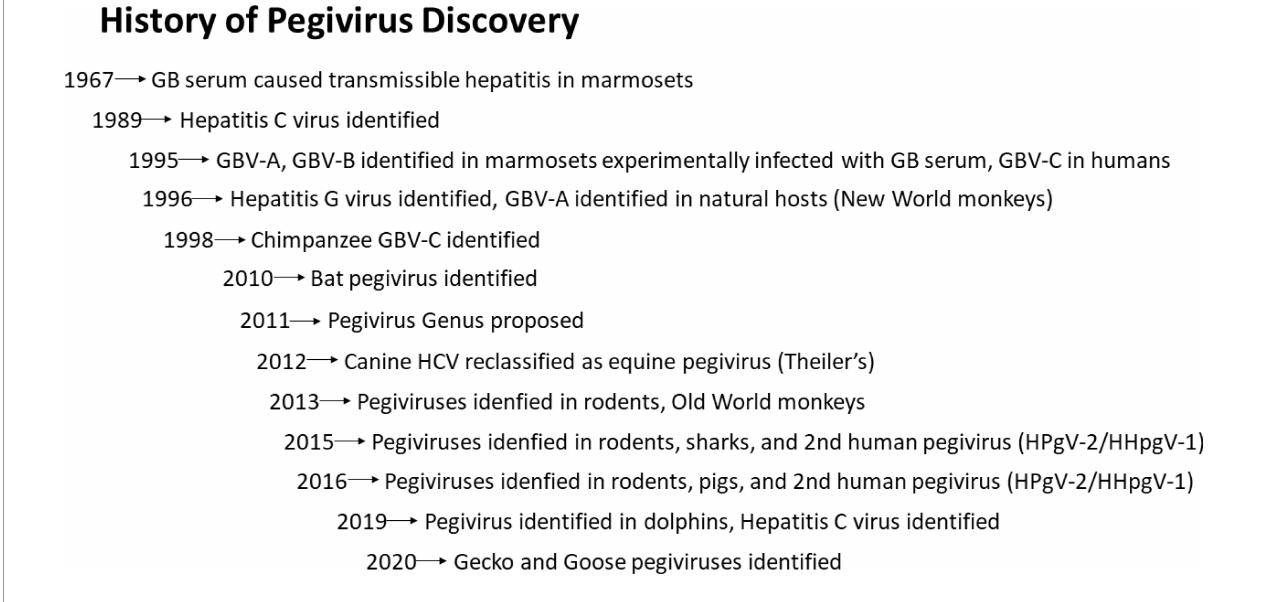
FIGURE 1 | History of Pegivirus